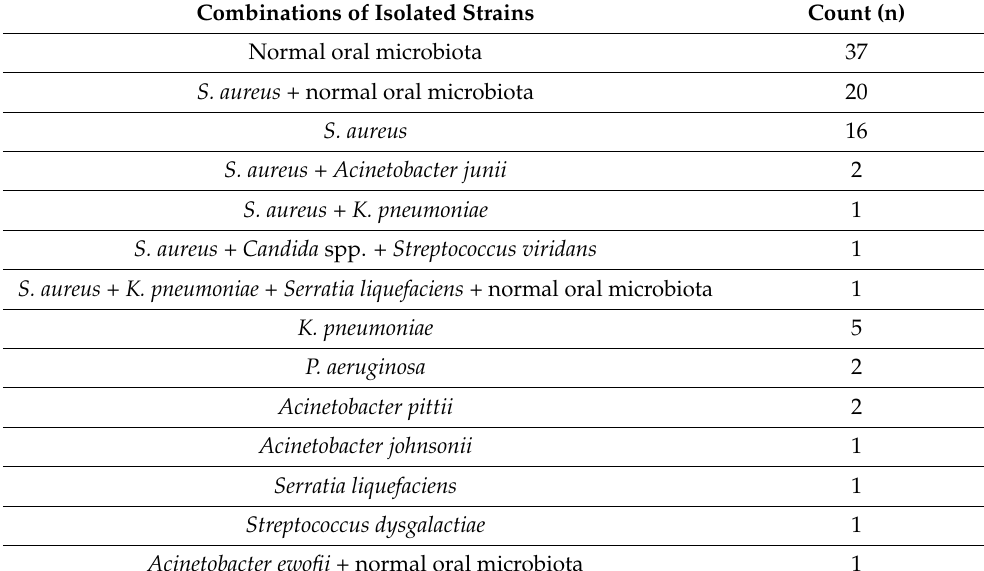
Table 1. Microorganisms isolated from tonsillar crypts of 91 healthy individuals.